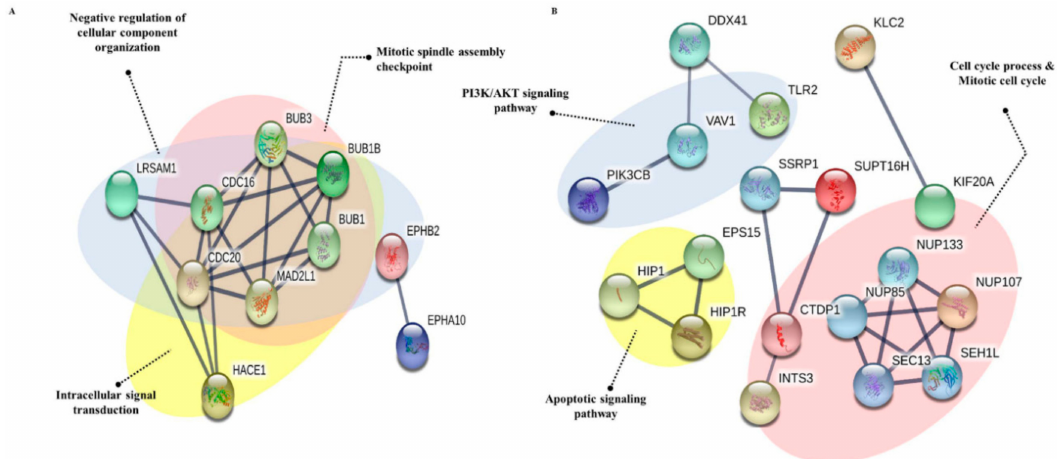
Figure 9. STRING analysis of significant proteins in AGS and MKN28 cells. ( A ) STRING database, version 10.5 (http://string-db.org) was used to determine the protein-protein interactions of the 13 proteins differentially expressed in AGS cells treated with PEC. ( B ) Protein-protein interactions of the 39 proteins differentially expressed in MKN28 cells treated with PEC. Interactions predicted with high confidence were included in the analyses, and proteins with no predicted interactions were